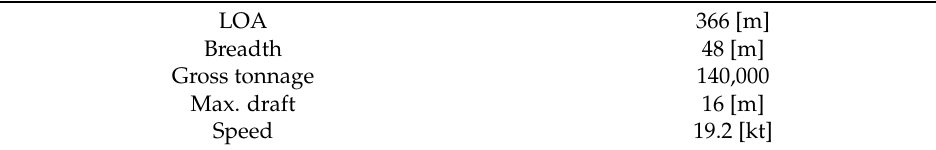
Table 1. Main parameters of the container